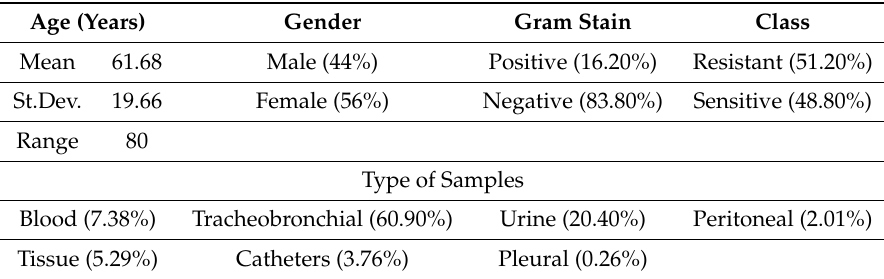
Table 1. Simple summary statistics of the